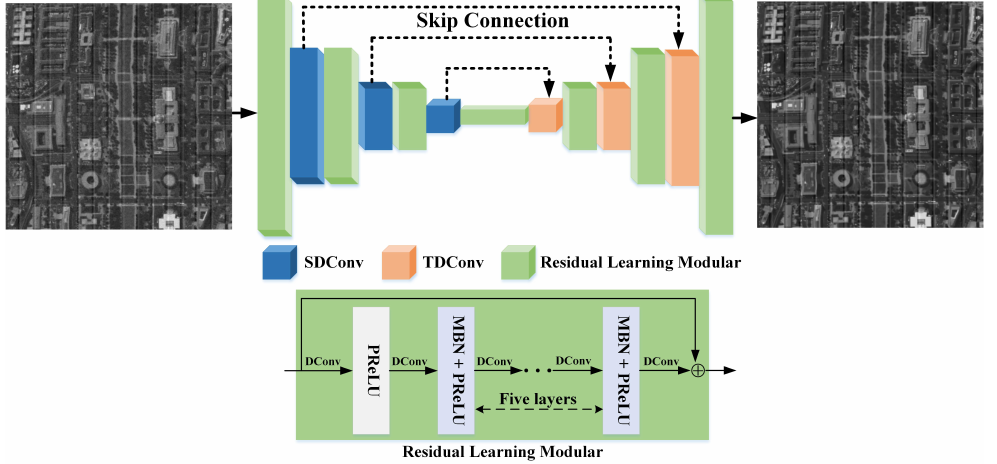
Figure 3. Flowchart of the proposed U-shape denoiser network. “SDConv” represents strided DConv while “TDConv” is transposed DConv, “ + (cid:13) ” is an adding operation. Note that: (1) In RLM, the batch normalization (BN) and rectified linear unit (ReLU) are respectively replaced by the momentum batch normalization (MBN) [78] and parametric rectified linear unit (PReLU), as MBN can solve the underfitting problem caused by a small batch size of BN while PReLU is utilized for the nonlinearity to generate high quality estimation with less filters. The dilation factors from the first layer to the last layer are respectively set to 1, 2, 3, 4, 3, 2, and 1, which aggregates multiscale contextual information without losing resolution or increasing the depth of the network. The equivalent receptive field of each layer is 3, 5, 7, 9, 7, 5, and 3. In RLM of each scale layer, five successive “MBN + PReLU” blocks are adopted. (2) The USD-Net has four-scale layers, 2 × 2 strided dilated convolution (SDConv) is employed between each downscaling layer while 2 × 2 transposed dilated convolution (TDConv) is exploited between each upscaling layer. (3) The same scale between SDConv and TDConv has an identity skip connection. (4) The channels in each scale layer are gradually increased from 64 to 128 to 256 to